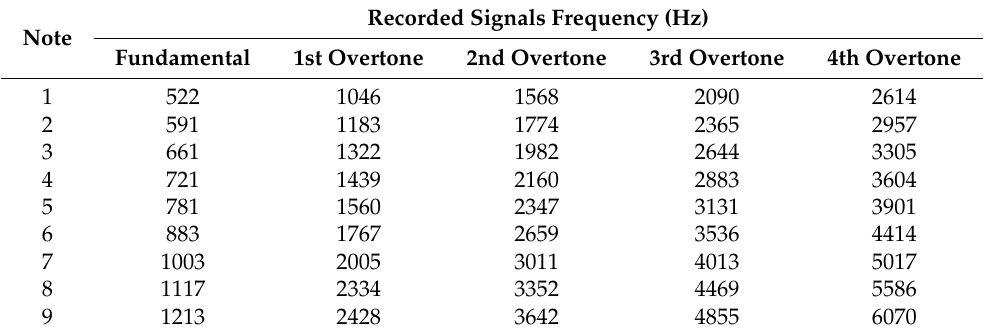
Figure 5. Spectral comparison of the synthesized signal without adopting the optimal correction factors (blue line, upper plot) and with adopting the optimal correction factors (blue line, lower plot) with the relative (note 6) recording (orange line). Table 1. The first five partials of the recorded signals per 9 notes, in Hertz.